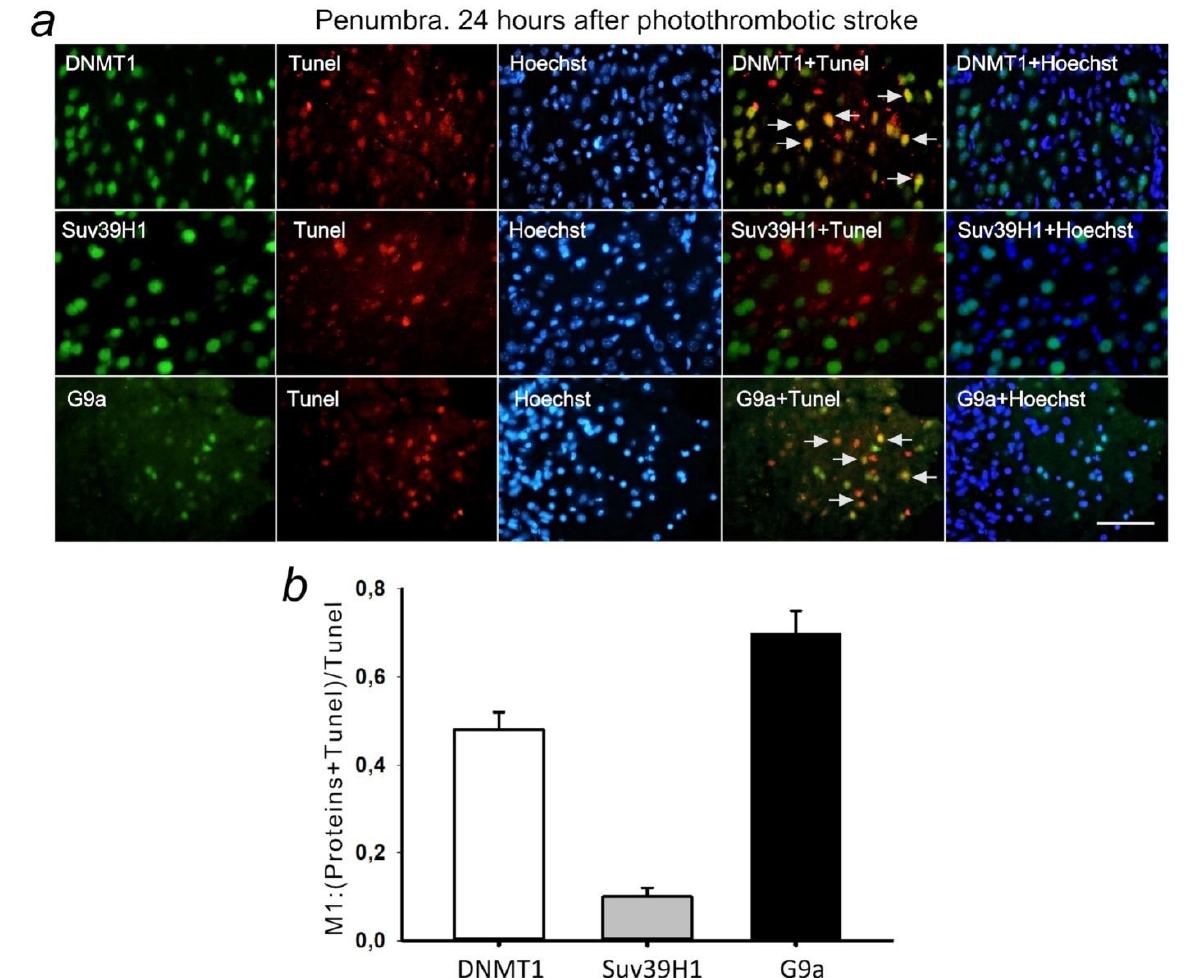
Figure 12. ( a ) Immunofluorescence of DNMT1, Suv39H1, G9a, and TUNEL-positive apoptotic cells, nuclear chromatin marker Hoechst 33342, and image overlay in the penumbra 24 h after photothrombotic stroke in the rat cerebral cortex. The scale bar is 100 μ m. Cells containing DNMT1 or G9a co-localized with the TUNEL-positive apoptotic cells (shown by white arrows). ( b ) Coefficient M1 of DNMT1, Suv39H1, or G9a co-localization with TUNEL in penumbra at 24 h after photothrombotic stroke. M ± SEM; n = 7.